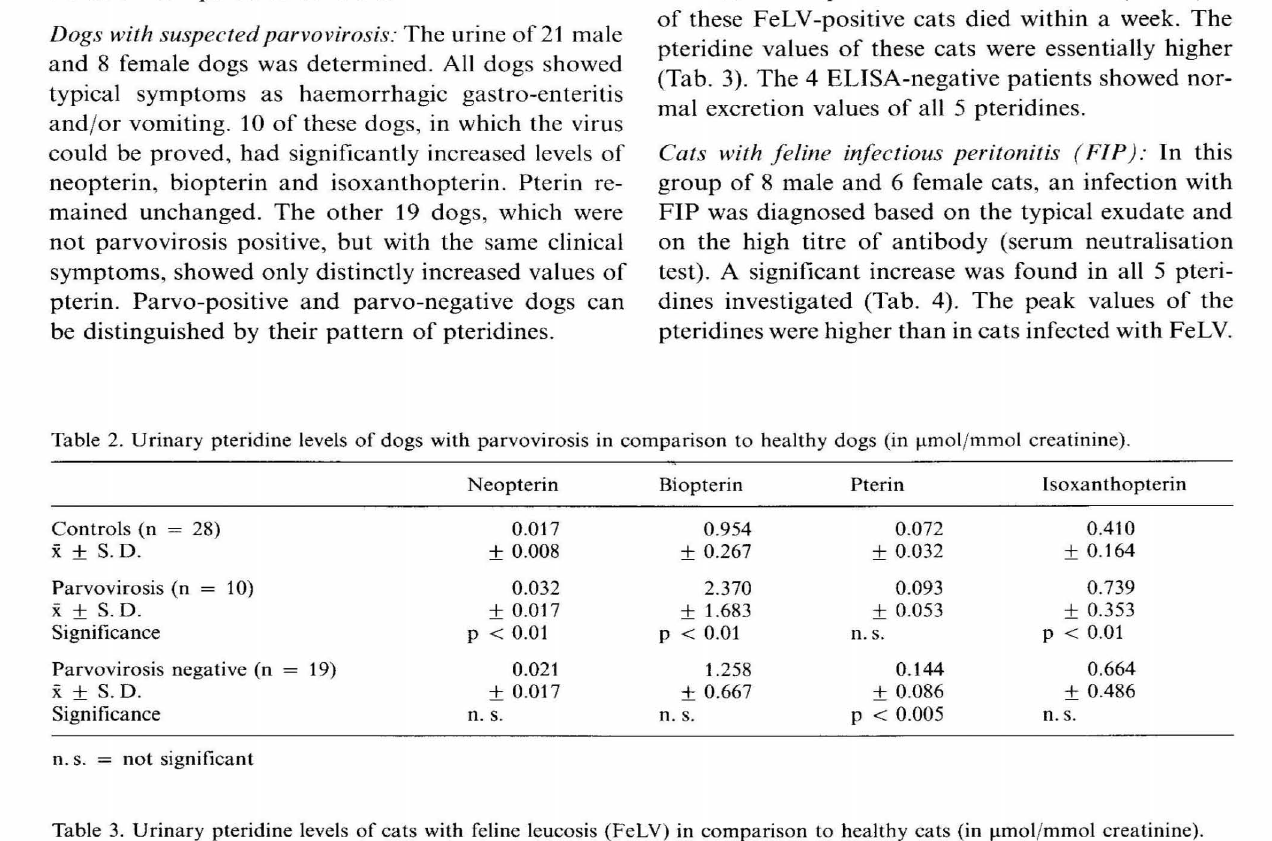
Table 3. Urinary pteridine levels of cats with feline leucosis (FeLV) in comparison to healthy cats (in Ilmol/mmol